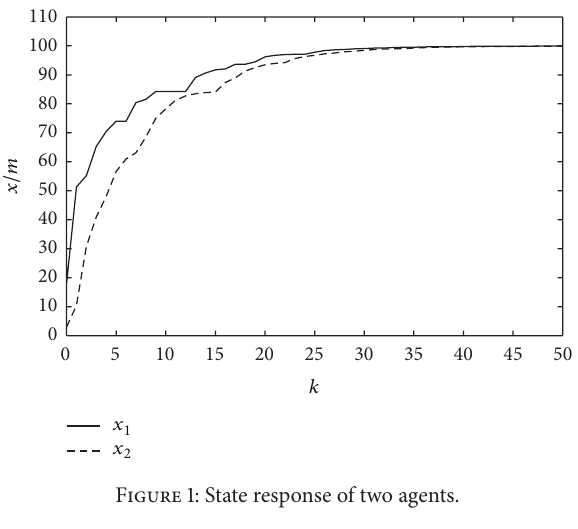
Figure 1: State response of two